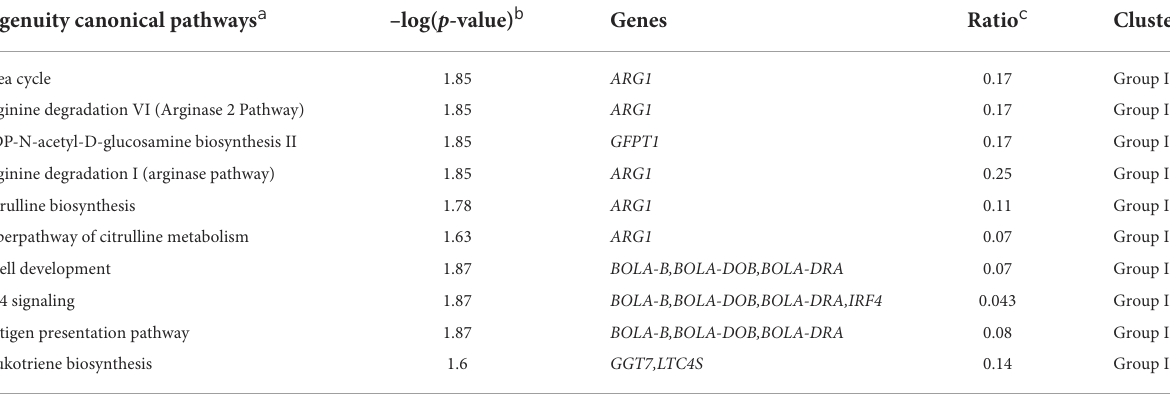
TABLE 5 Significantly enriched pathways between HMUg and LMUg cows based on gene Groups I and II derived from ruminal host-microbiota interaction analysis (Figure 3). Ingenuity canonical pathways